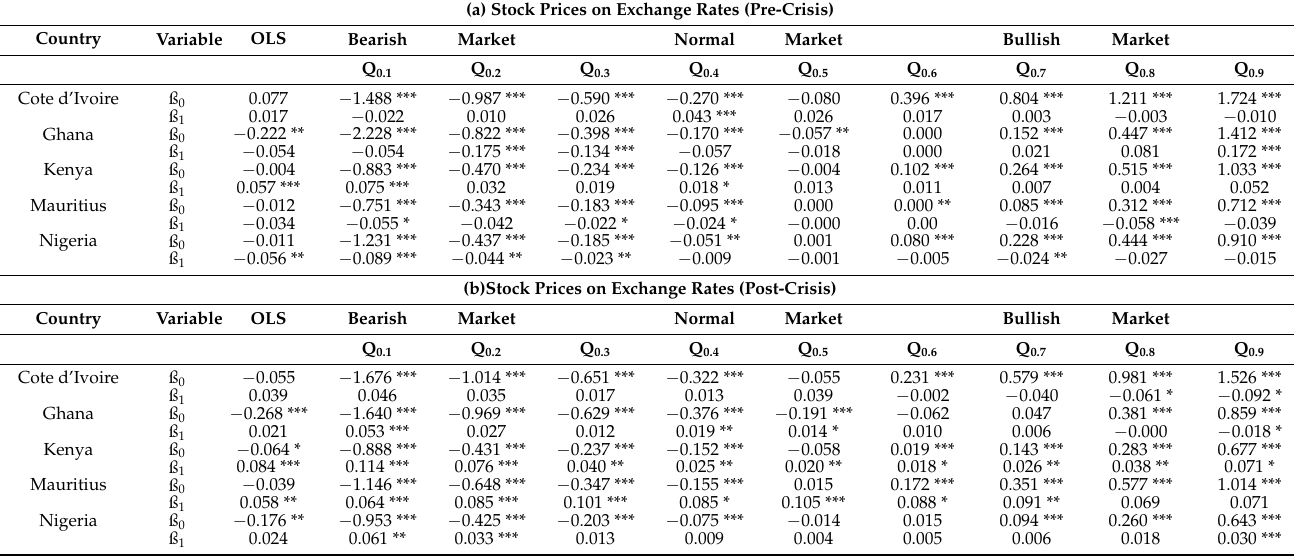
Table 14. Effects of ( a ) stock prices on exchange rates (pre-crisis) and ( b ) stock prices on exchange rates (post-crisis). (a) Stock Prices on Exchange Rates (Pre-Crisis) Country Variable OLS Bearish Market Normal Market Bullish Market